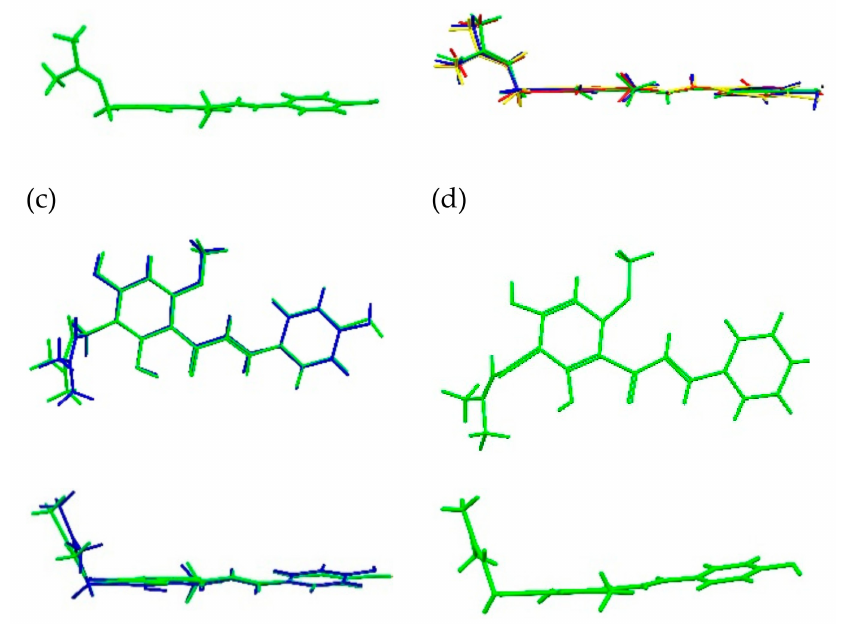
Figure 3. Side and top views of the XN molecules in ( a ) XN − NIC, ( b ) XN − GA, ( c ) XN − AC, and ( d ) XN − CF.